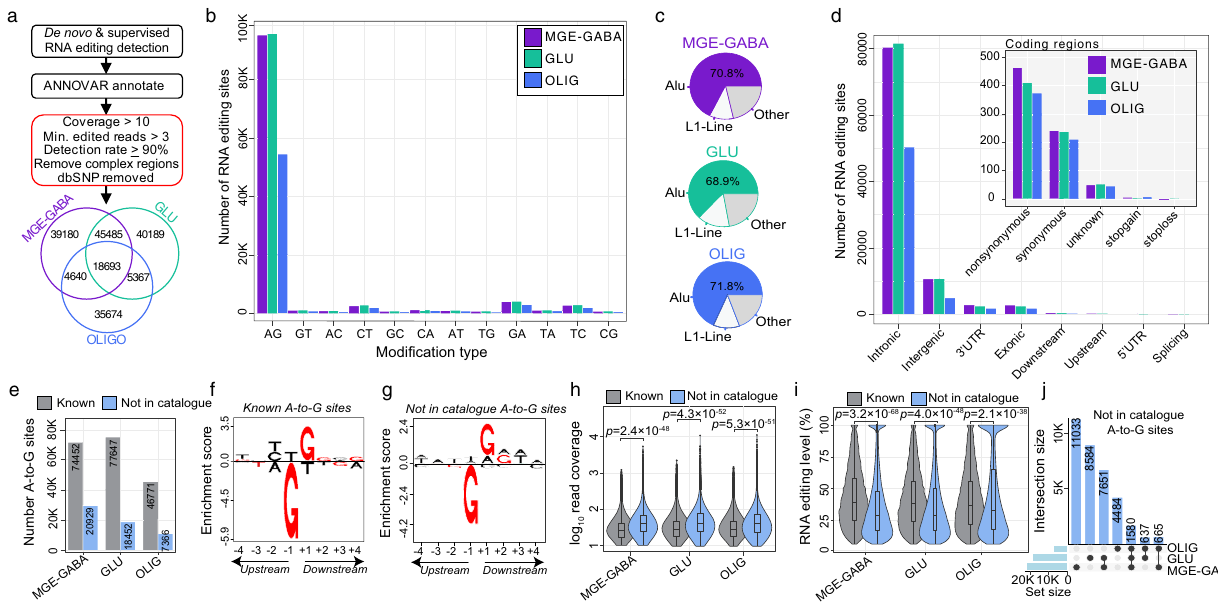
Fig. 2 Identi fi cation and annotation of cell-speci fi c RNA editing sites. a Work fl ow for detecting high-con fi dence cell type-associated editing sites combining de novo calling and supervised RNA editing detection. The total number of sites detected per cell type are displayed in the Venn diagram. Data in all panels were derived from the human PFC ( n = 9 biologically independent samples). b The total number of RNA editing sites by modi fi cation type. c The fraction of sites that map to Alu and L1-line elements relative to all other elements. d The total number of editing sites by genic region. The inset plot shows the breakdown in coding regions. e The number of A-to-G editing sites (y-axis) were grouped based on catalog annotation (known or not in catalog) and independently numerated per cell type. Local sequence motif enrichment analysis for both f known and g not in catalog sites depicting a depletion of guanosine -1bp upstream and enrichment + 1 bp downstream of the target adenosine. Known and not in catalog sites for each cell population according to h read coverage (log 10 , y-axis) and i editing level (%, y-axis). Two-sided Mann – Whitney U -tests computed signi fi cance in mean differences in read coverage differences and editing rates between known and not in catalog sites within MGE-GABA, GLU, and OLIG populations and associations with a p value <0.05 were deemed signi fi cant. Box plots show the medians (horizontal lines), upper and lower quartiles (inner box edges), and 1.5 ×